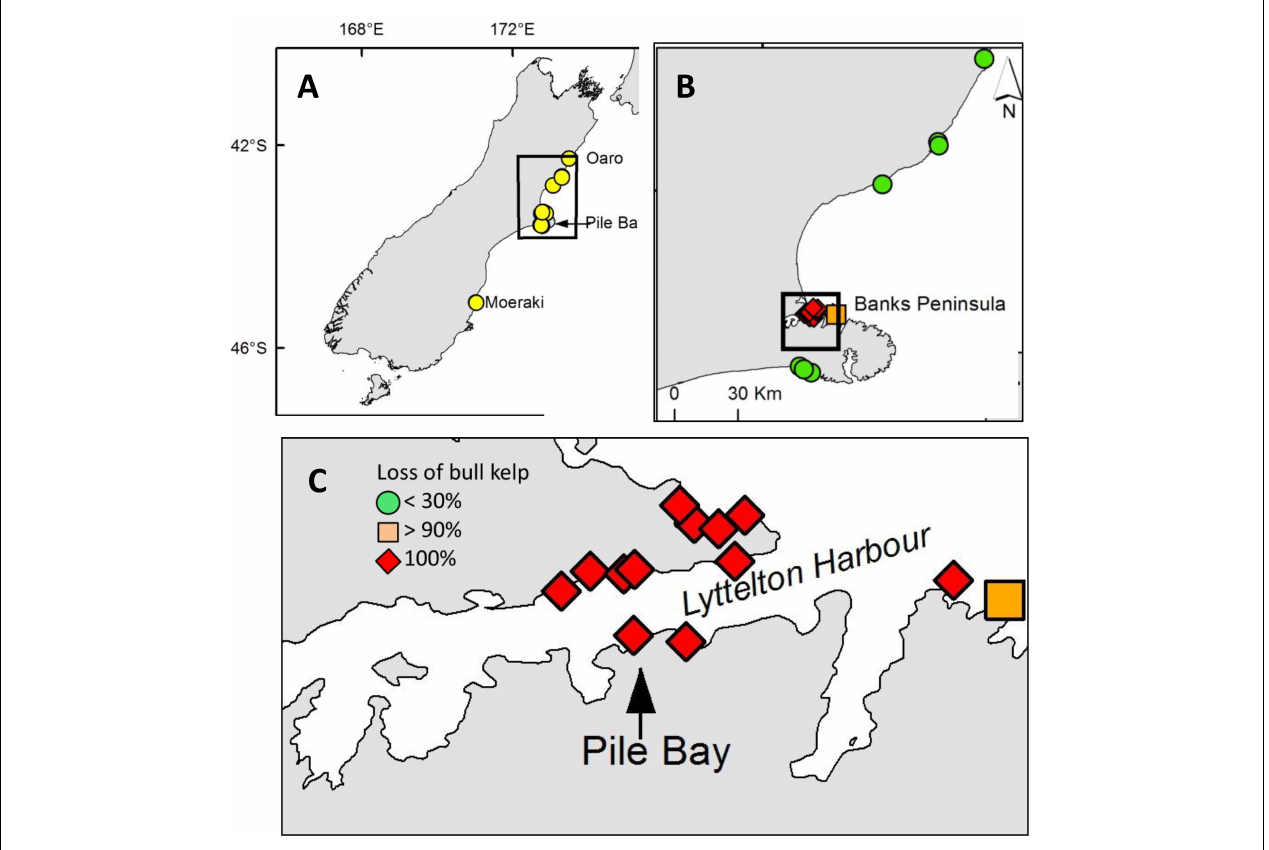
FIGURE 5 | (A) Surveyed bull kelp sites on the South Island of New Zealand; drone surveys were done at Oaro, Pile Bay and Point and Kaik reefs in Moeraki. (B) Close-up of reefs around Banks Peninsula where detailed searches for live bull kelp blades and dead “ghost holdfasts” were done. (C) Close-up of sites with reef-wide extinctions of bull kelp around Pile Bay in Lyttelton